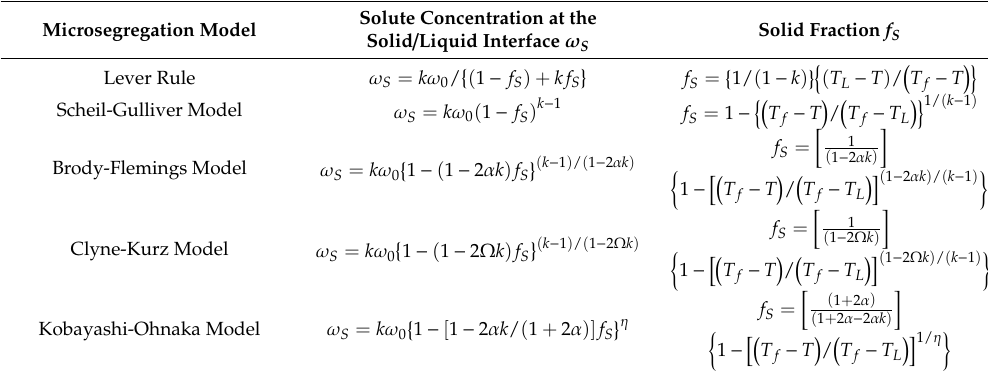
Table 1. Microsegregation models and